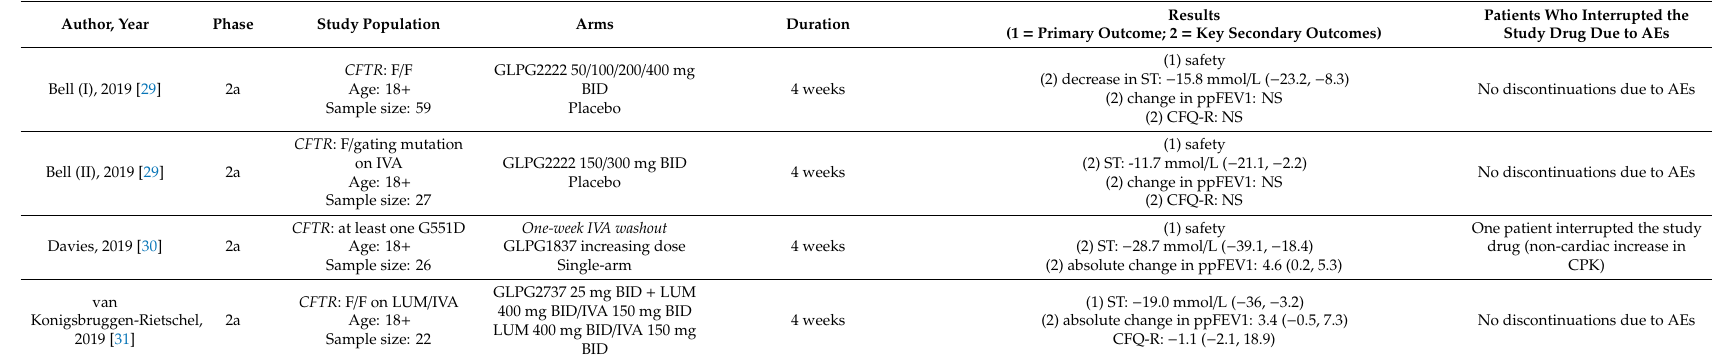
Results (1 = Primary Outcome; 2 = Key Secondary Outcomes)